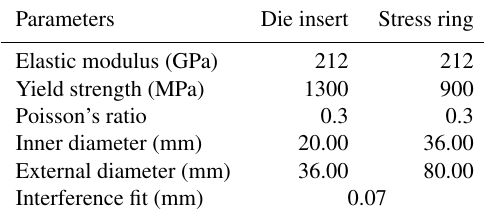
Table 1. Parameters of the combined die. Parameters Die insert Stress